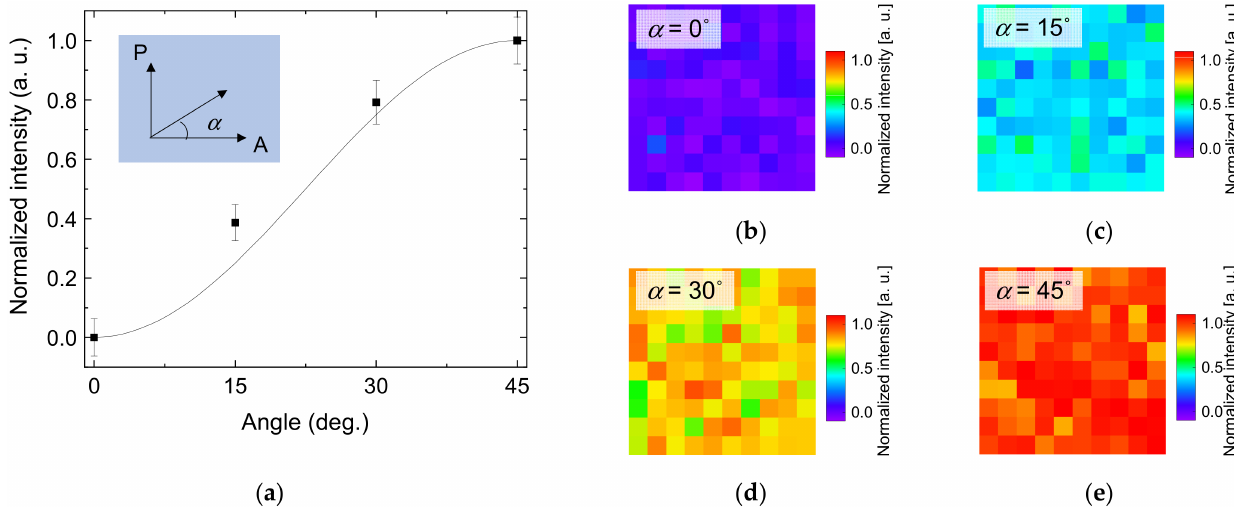
Figure 6. ( a ) Normalized transmitted THz intensity when rotating the LCP sample and theoretical results (solid line) calculated by using Equation (3). ( b – e ) Transmission images when rotating LCP sample in steps from 0 ◦ to 45 ◦ ( α = 0 ◦ , 15 ◦ , 30 ◦ , 45 ◦ , respectively). Images were obtained with raster-scanning